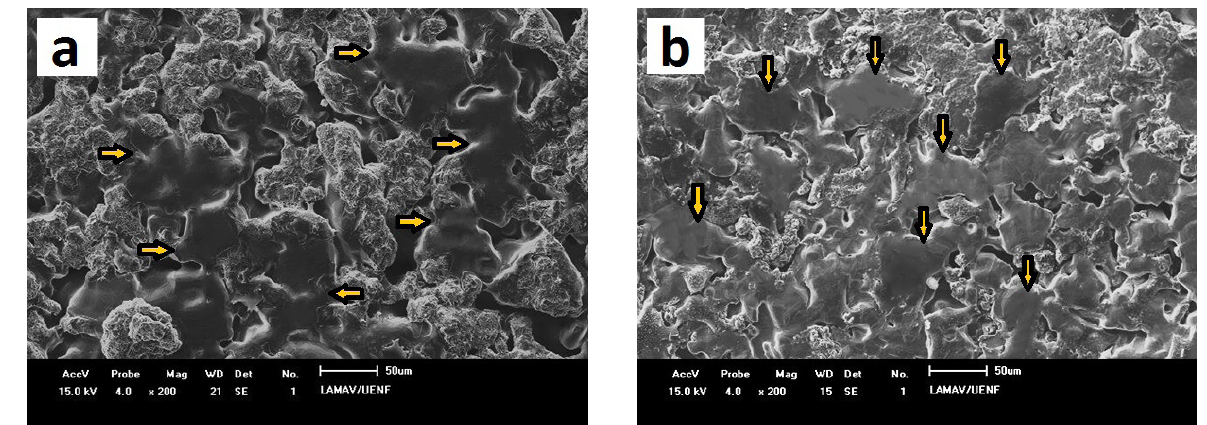
Figure 8 - Samples Ti ( a ) and Ti-2D ( b ) 24 hours after inoculation of Vero cells in 200x magnification. Arrows indicate cells on the surface of the